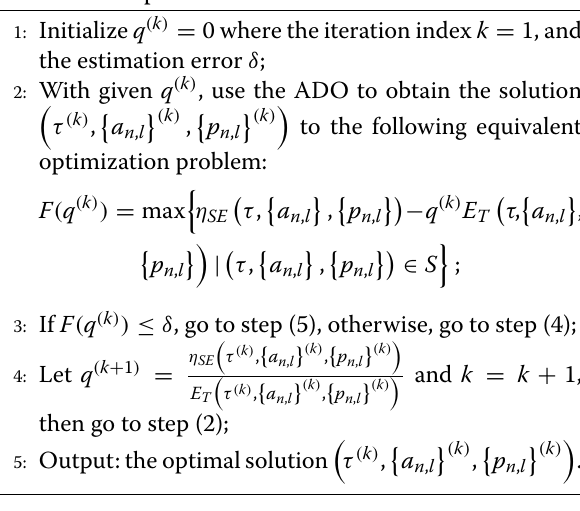
Algorithm 2 Joint optimization algorithm based on Dinkelbach’s optimization